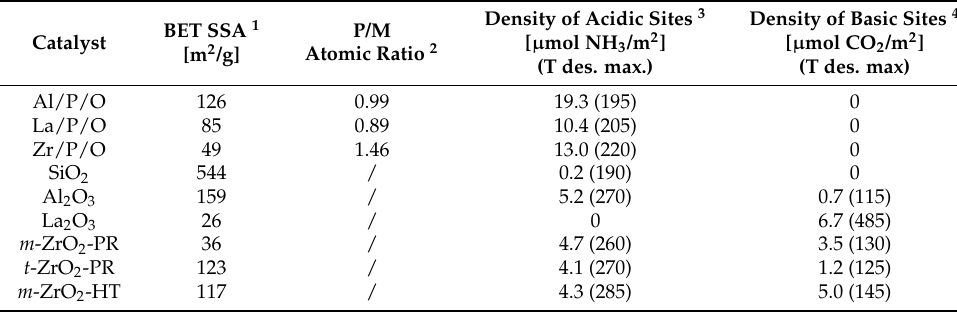
Table 1. Physicochemical features of fresh